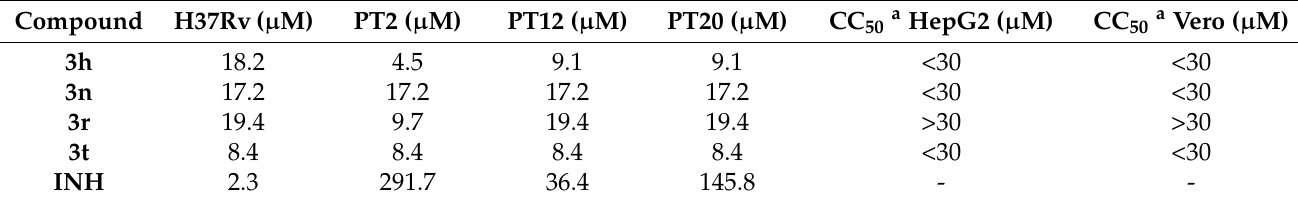
Table 1. In vitro activity of the selected 1 H -indoles against M. tuberculosis H37Rv and MDR strains and an evaluation of the viability of HepG2 and Vero cells.